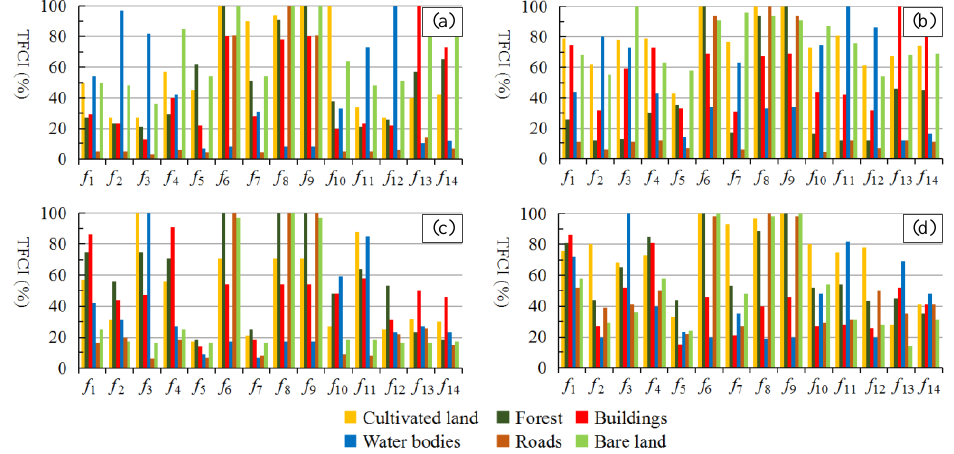
Figure 12. The results of TFCI values of six types of surface objects with the different image data source. ( a , b ) are the results from the aerial images in March 2009 and September 2013, respectively. ( c , d ) are the results from the QuickBird images in March 2009 and September 2017, respectively.